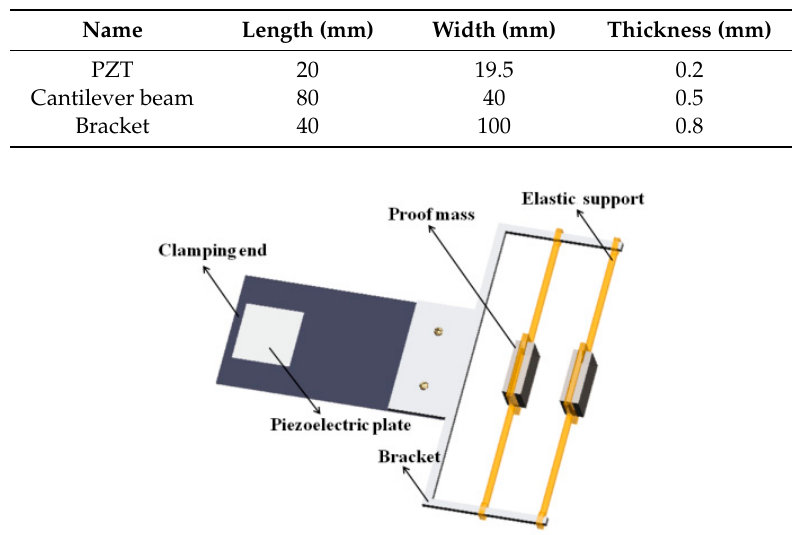
Figure 1. Schematic of the proposed piezoelectric vibration energy harvester (PVEH).